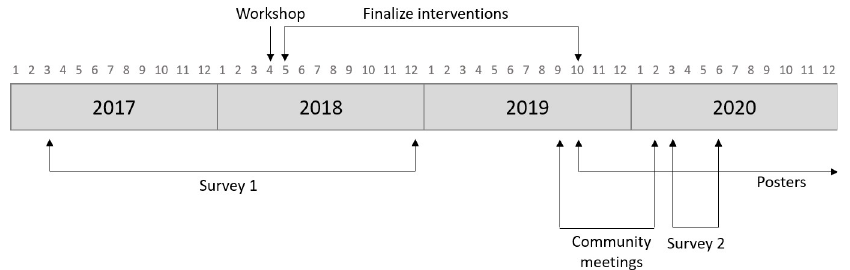
Fig 1. Study design and timeline. Survey 1 consisted of the KAP, EMIC-CSS, SDS, communication needs assessment, in-depth interviews, and focus group discussions. Survey 2 consisted of the KAP, EMIC-CSS, SDS, intervention evaluation tool, in-depth interviews, and focus group